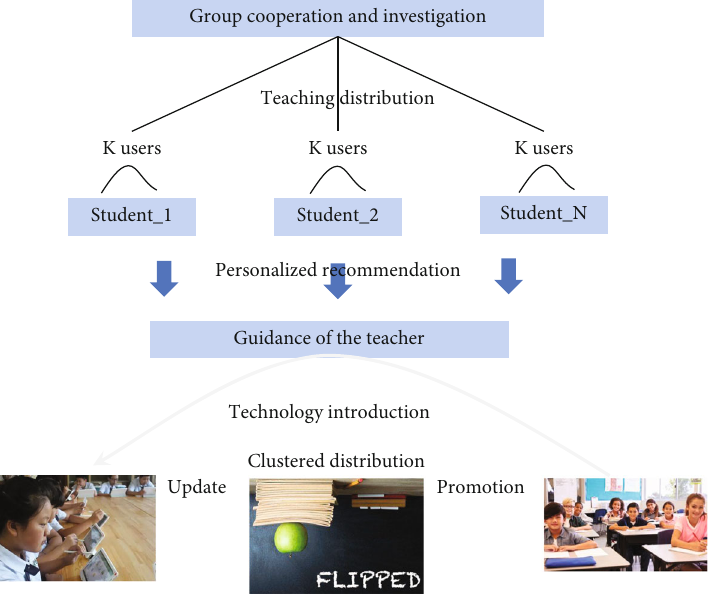
Figure 2: Classroom phase implementation.